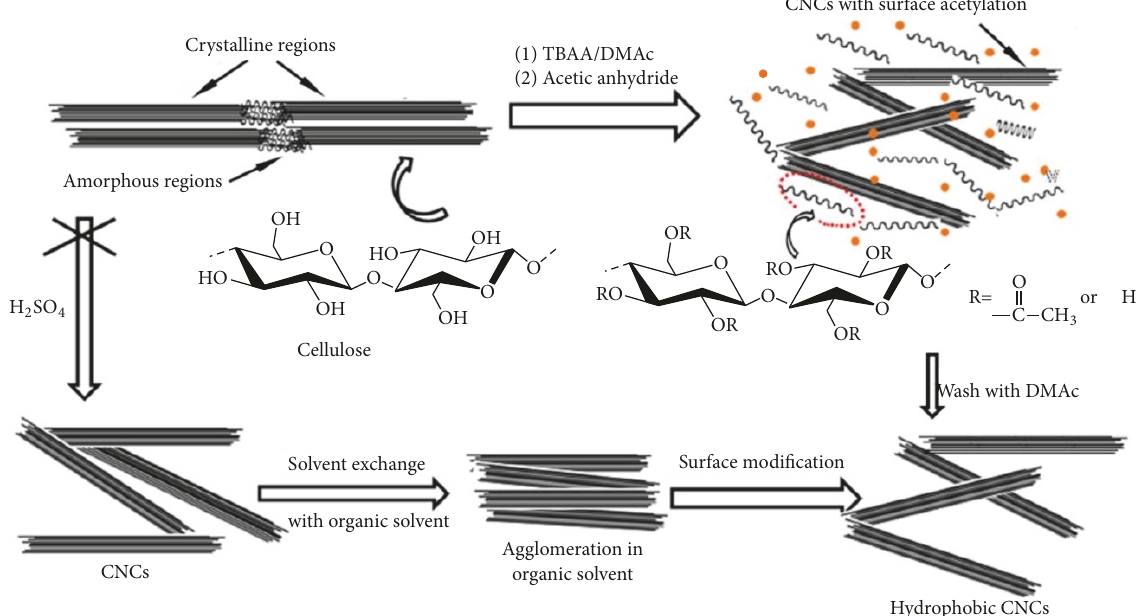
Figure 6: One-pot preparation of hydrophobic CNCs in TBAA/DMAc with acetic hydride (upper part) and the more typical route (lower part)